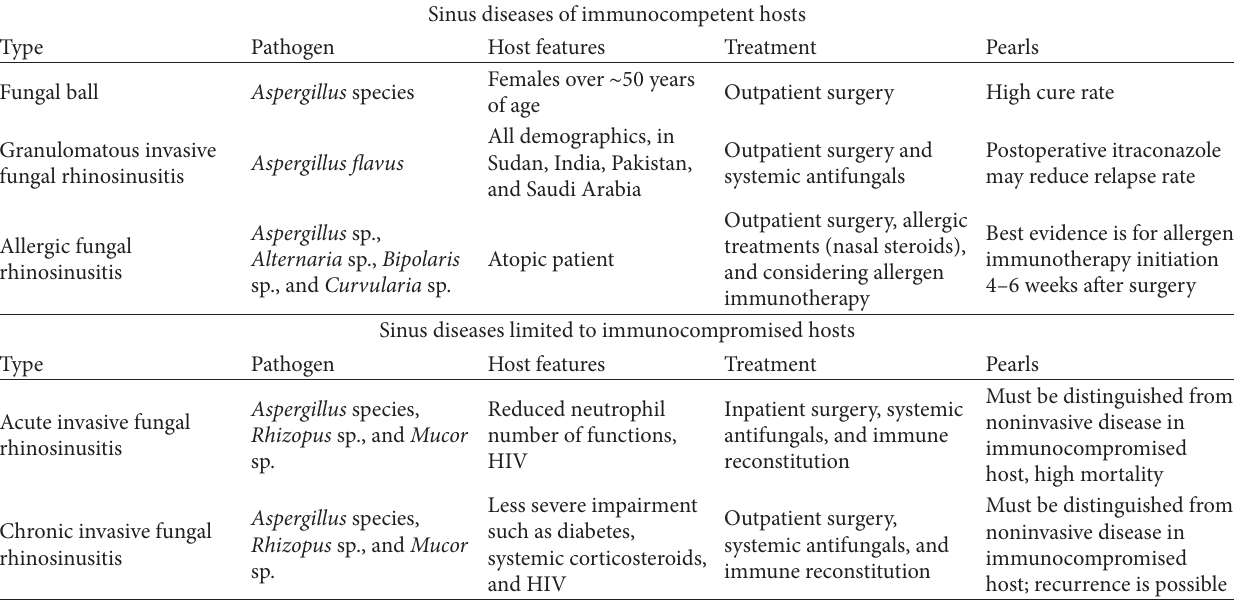
Table 1: Review of sinus disease categories and